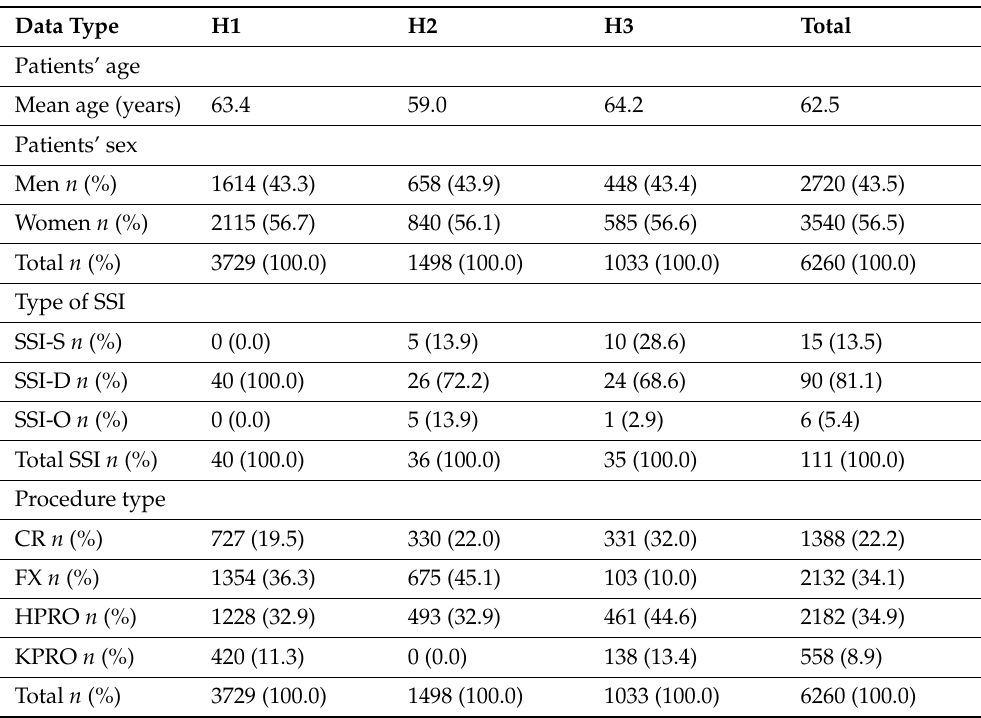
Table 1. Number, type, and incidence of SSI considering variables: sex, age, and surgery type, in the studied hospitals in